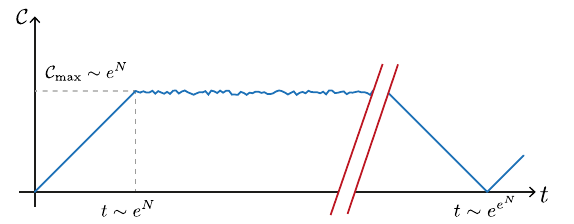
Fig. 3 Illustrationofthetimedependenceofcomplexityduringchaotic Hamiltonian evolution. The complexity grows linearly until it reaches its maximal value which is exponential in the number of degrees of freedom, and is expected to decrease significantly around the quantum recurrence time which is doubly exponential in the number of degrees of freedom in the system, once the full unitary group has been explored